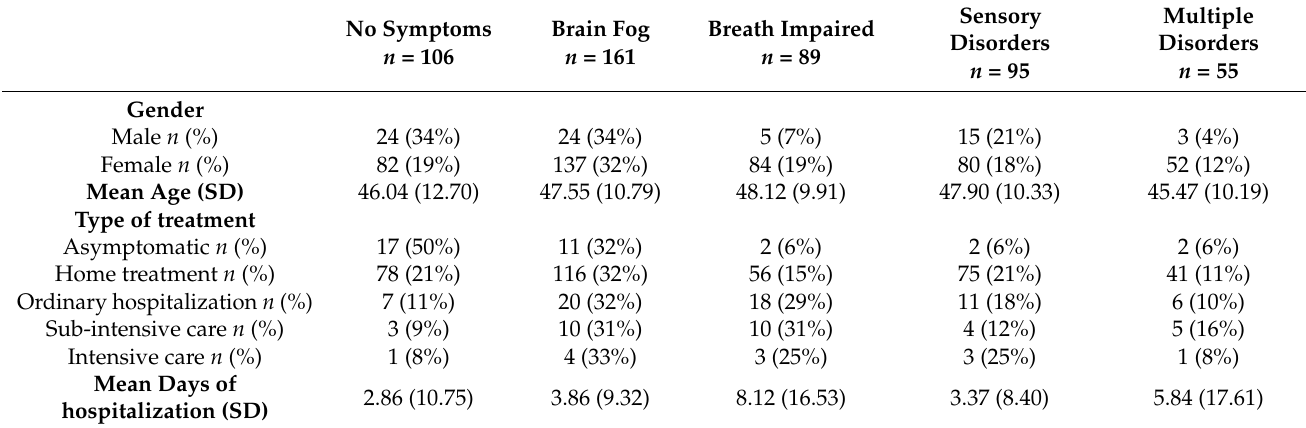
Table 3. Symptom classes in terms of the sociodemographic and clinical characteristics ( N = 506).